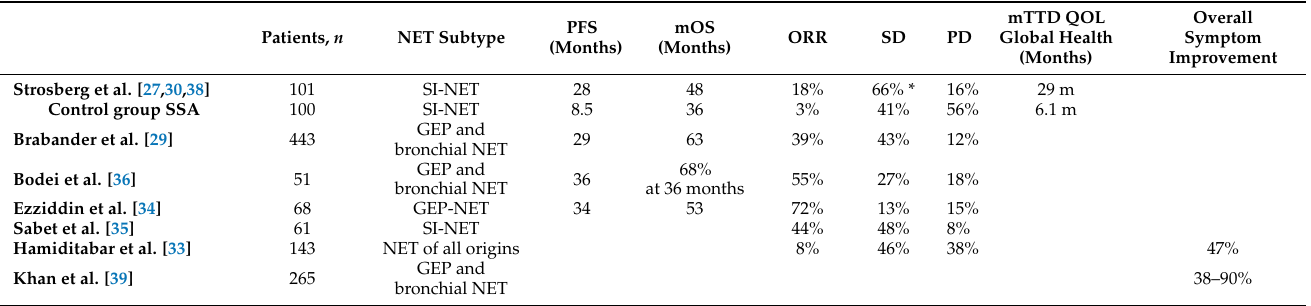
Table 1. Overview of tumor control and symptom control following PRRT as described in key phase II and III clinical